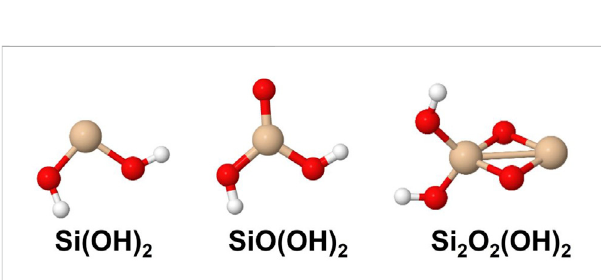
Hydroxylated silicon oxide species included in the present study. Silicon atoms are shown in beige, oxygen atoms in red and hydrogen in